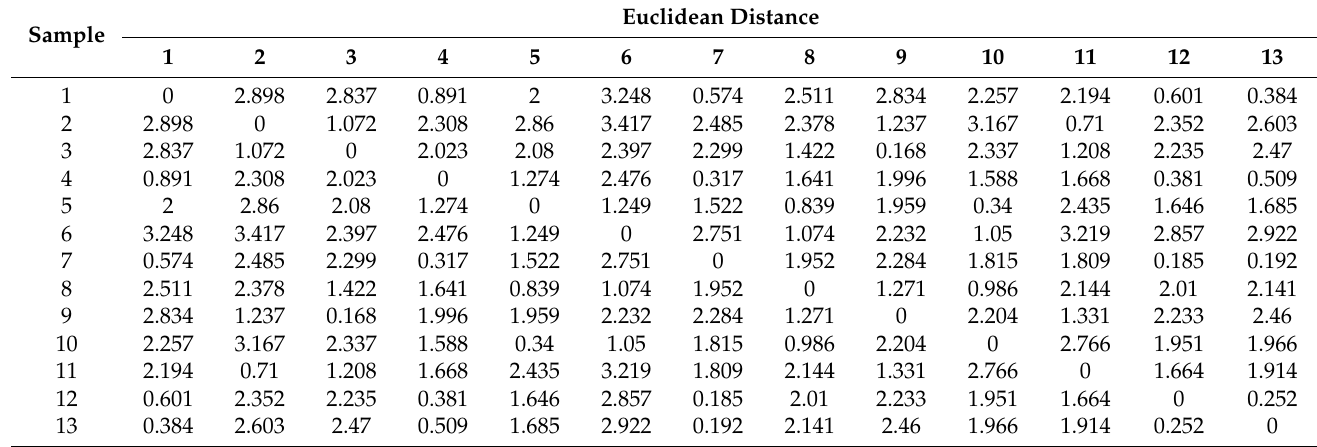
Table 14. Matrix of Euclidean distances between each sample.